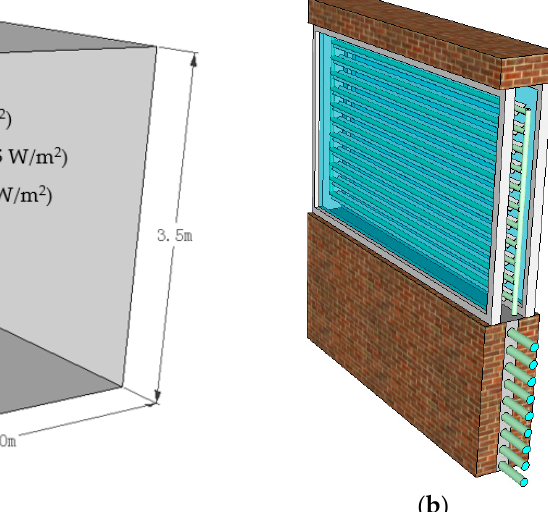
Figure 2. Configuration of the simulated office: ( a ) Office with traditional envelope; and ( b ) Synthetic pipe-embedded envelope.